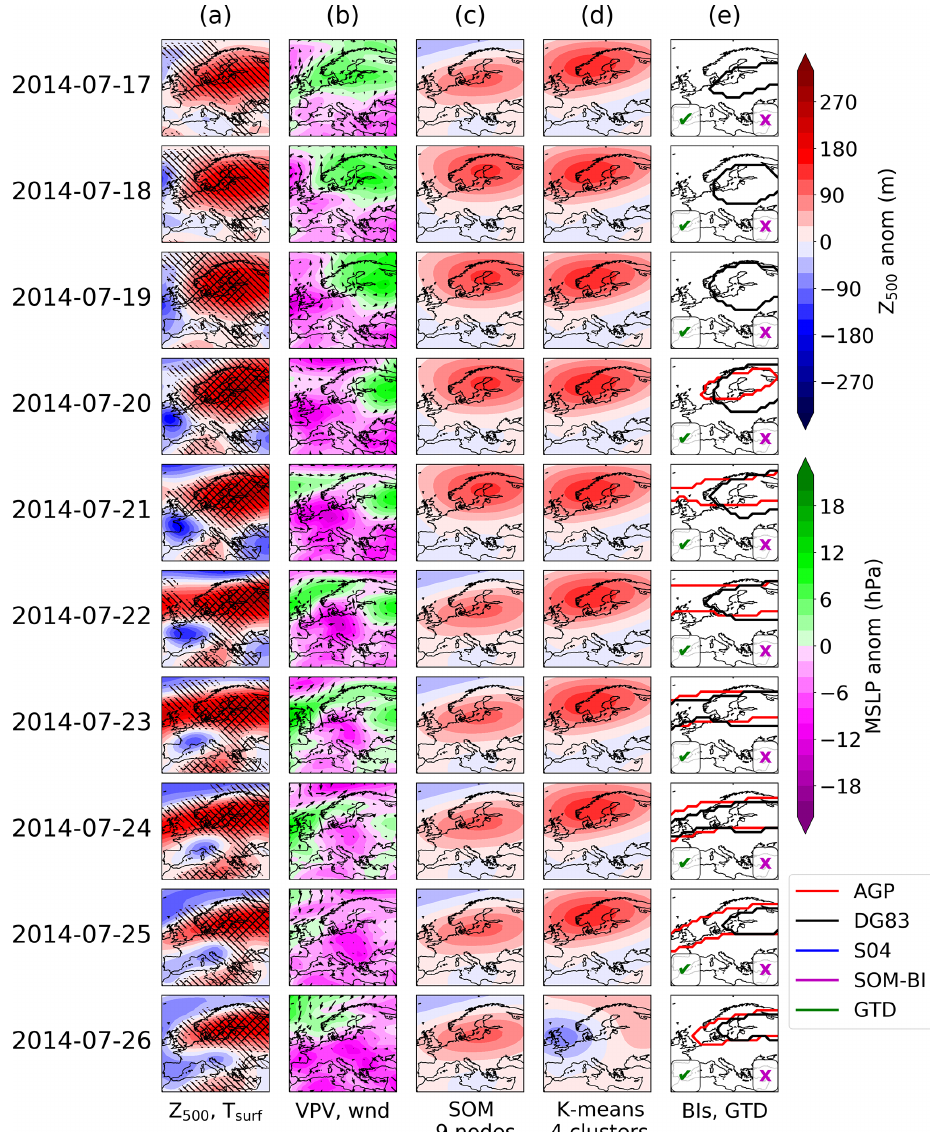
Figure A2. As with the case studies shown in Figs. 5 and 6 but for a heat wave in UKESM.